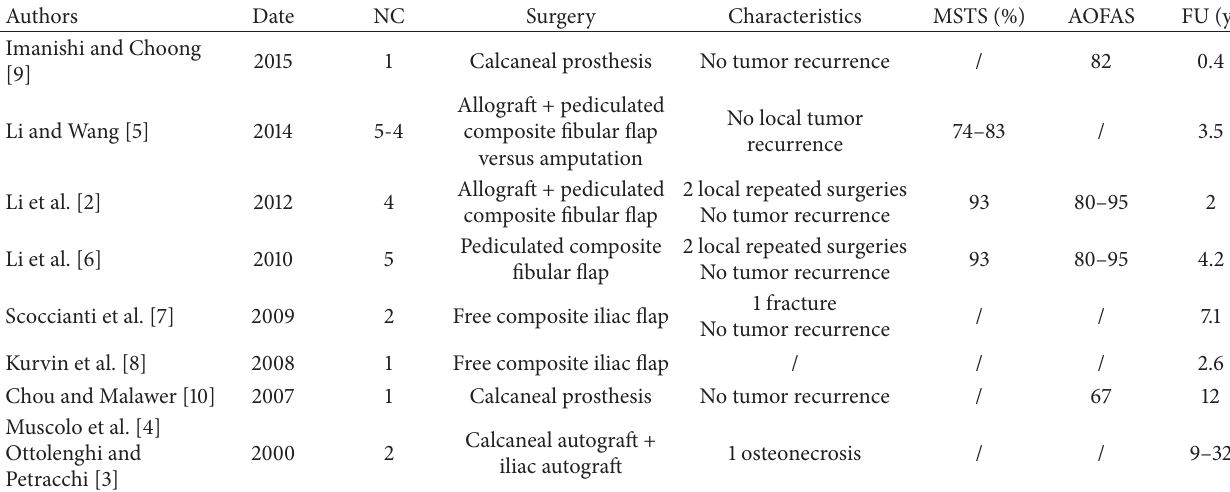
Table 1: Review of the literature of the different options of reconstruction following calcanectomy.